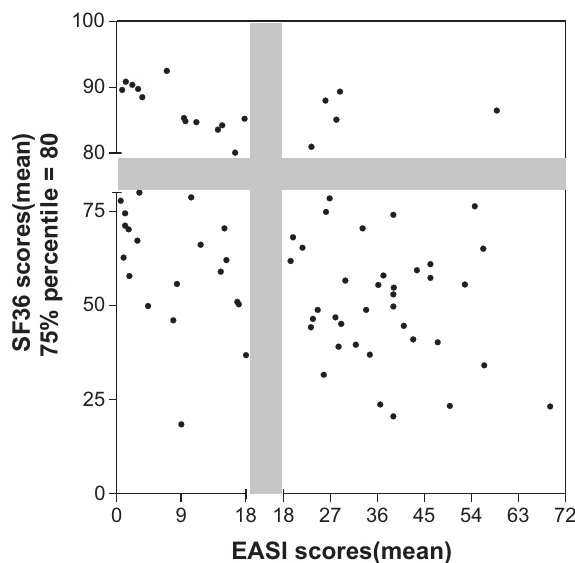
Figure 3 - Selection of subgroups according disease severity, as expressed by EASI scores, and QoL, as expressed by mean domains SF36 values. Dashed areas used for better visualization.